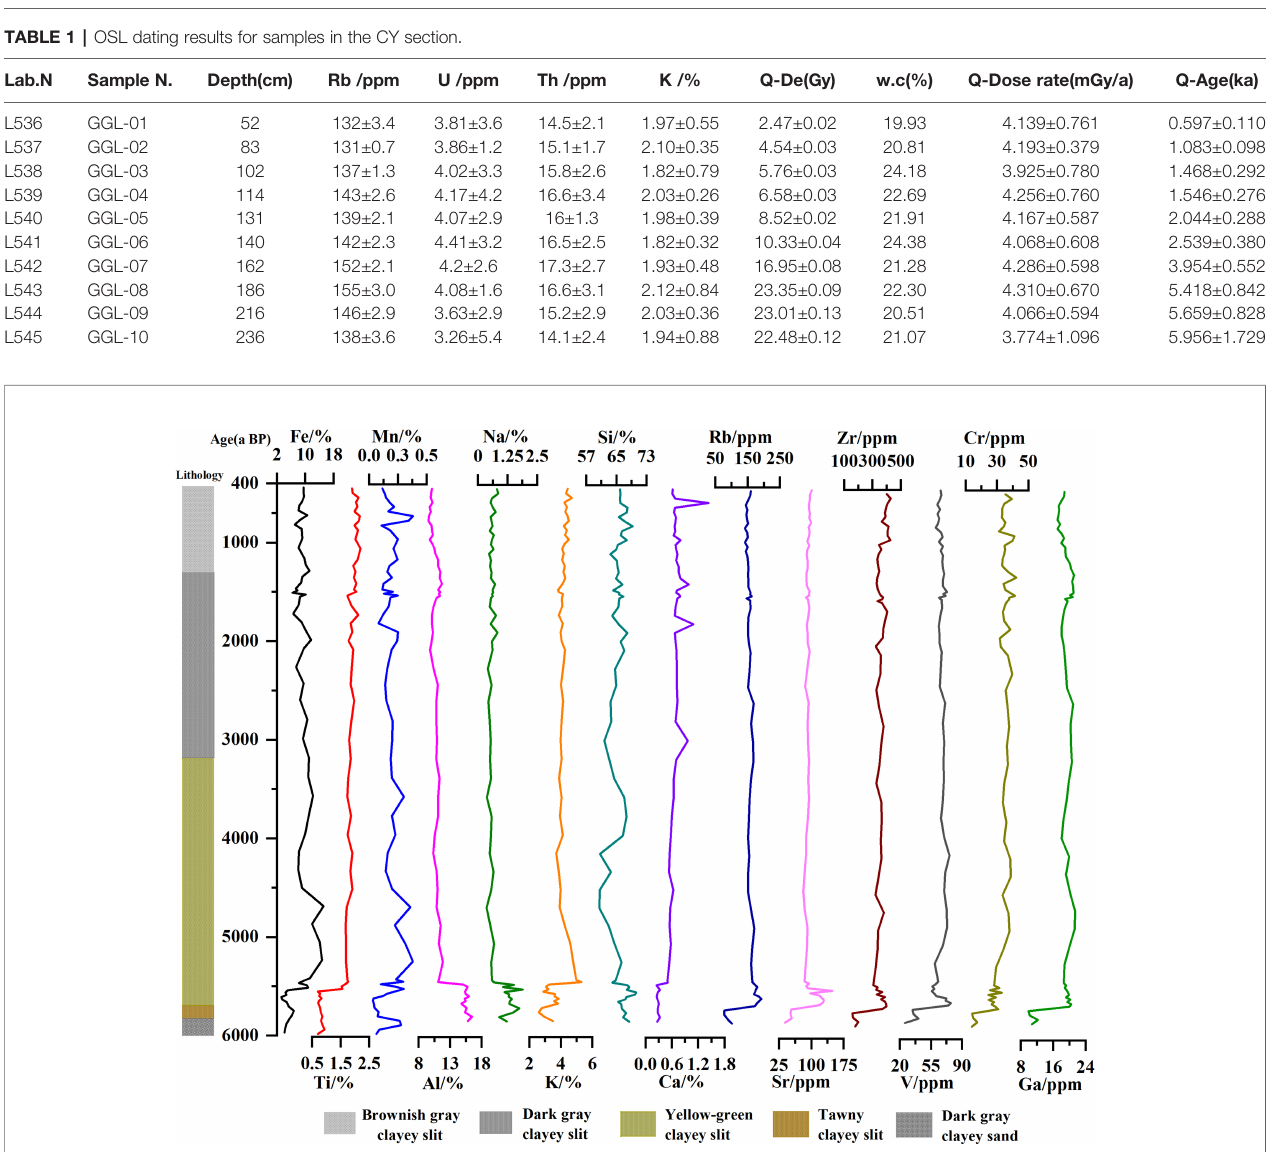
FIGURE 3 | Stratigraphic sequence and major element concentrations of sediments in the GGL pro fi